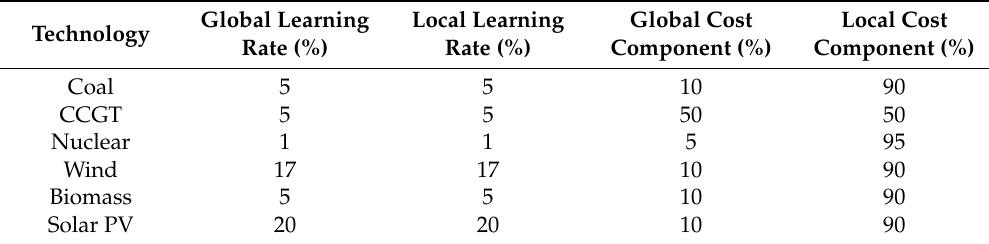
Table 9. Global and China’s learning rates and cost components